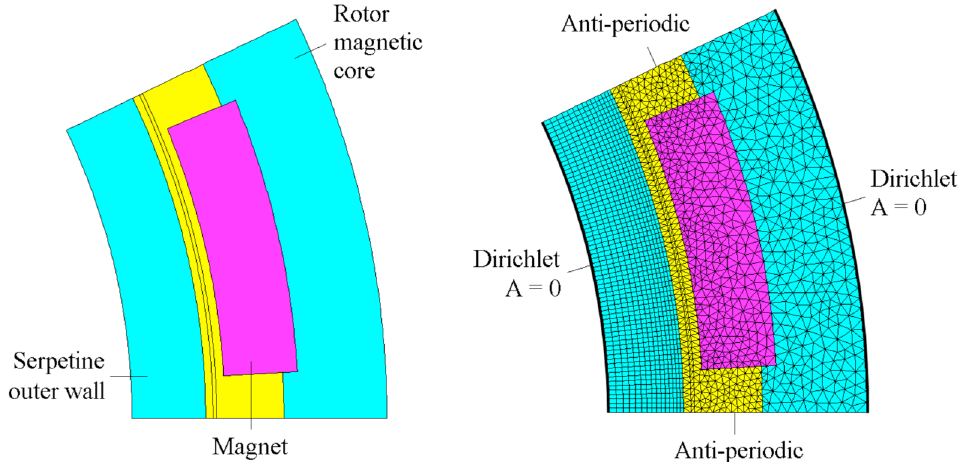
Fig. 2. Computation domain of 2D FE analysis, mesh and boundary